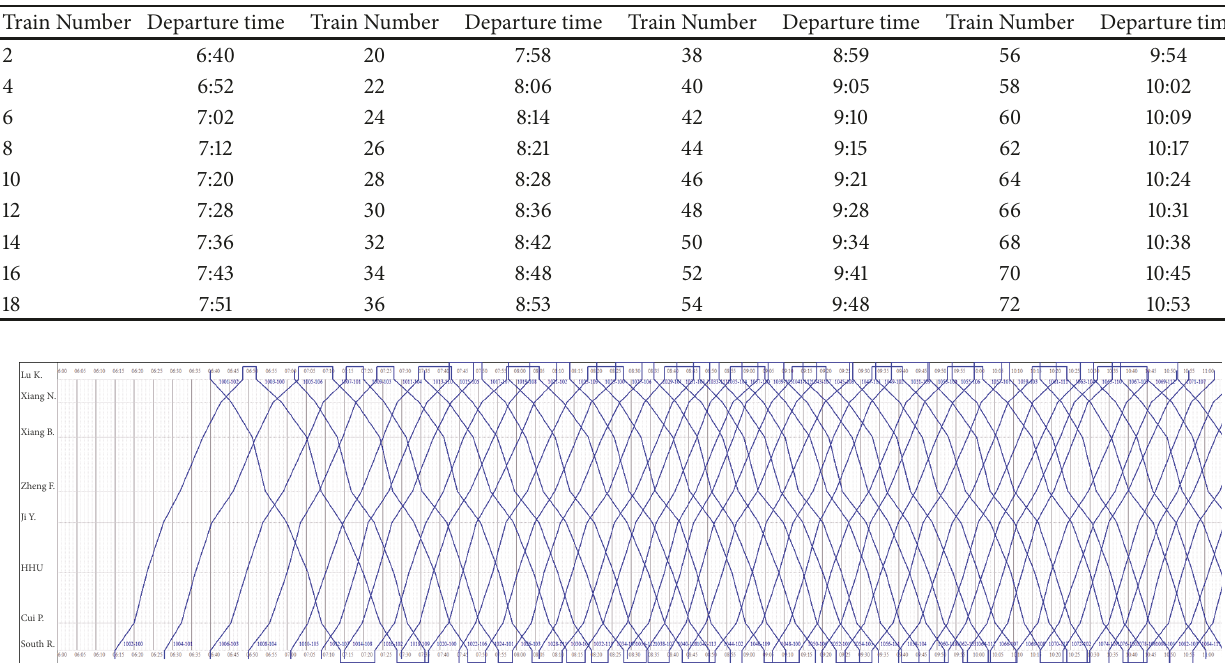
Figure 3: Train running chart based on the